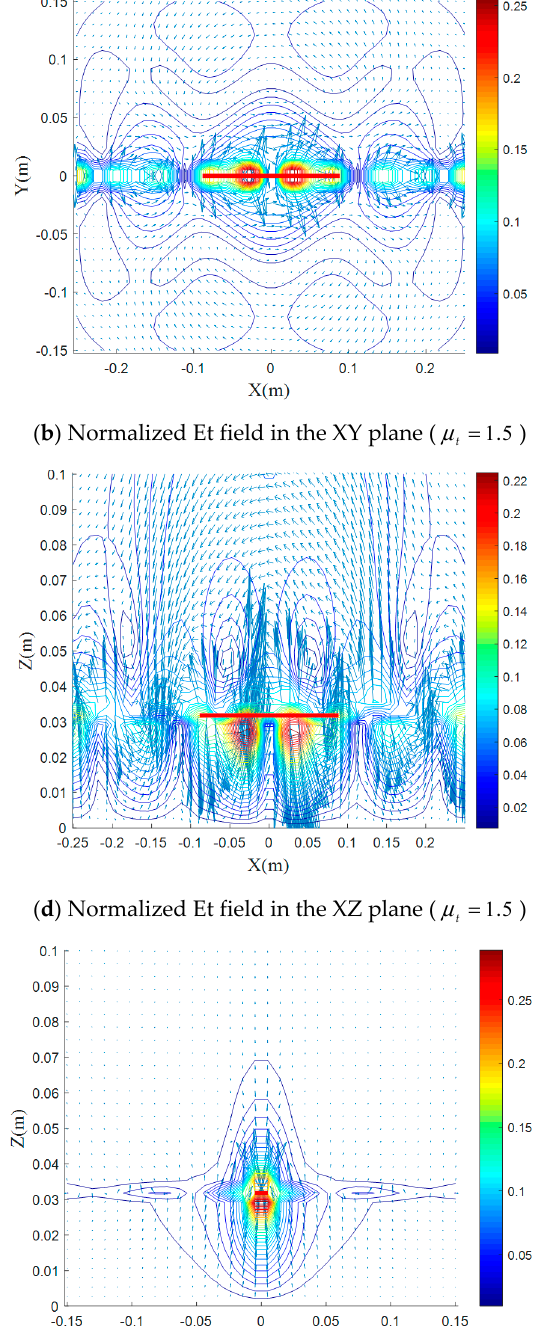
Figure 8. ( a – f ) Normalized electric field distributions for various values of XZ, and YZ planes.